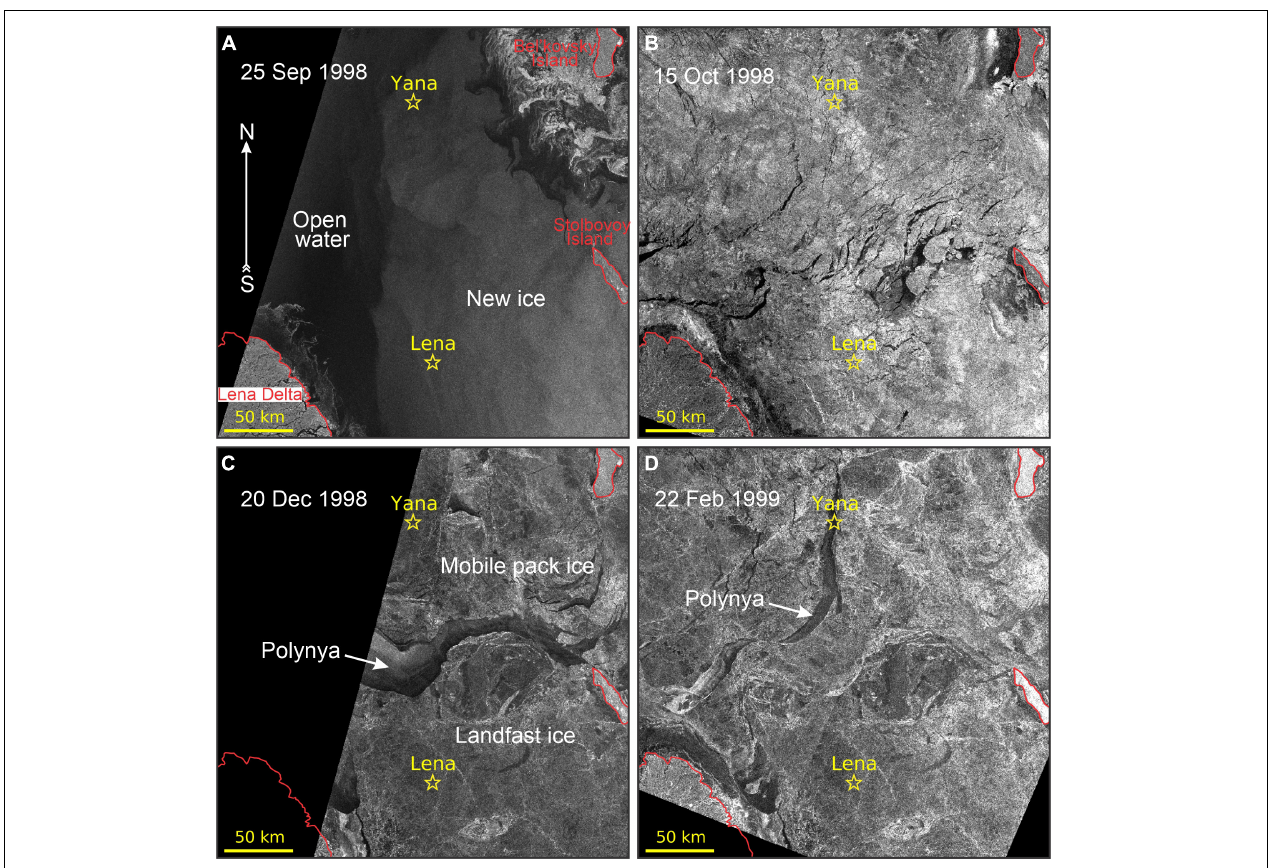
FIGURE 5 | RADARSAT-1 ScanSAR satellite images show the evolution of ice conditions in the Laptev Sea between September 1998 and February 1999: (A) 25 September 1998, (B) 15 October 1998, (C) 20 December 1998, and (D) 22 February 1999. Yellow stars depict moorings Lena and Yana. (B) Low radar backscatter area corresponds to calm open water. The gray strips in (C,D) are associated with a thin sea-ice newly formed in leads and polynya area. In (C,D) polynya delimited the landfast ice area. The mobile ice pack is located offshore of the landfast ice. Red lines indicate the coastline of the Lena Delta and Bel’kovsky and Stolbovoy islands also shown in Figure 1B . © Canadian Space Agency (CSA)